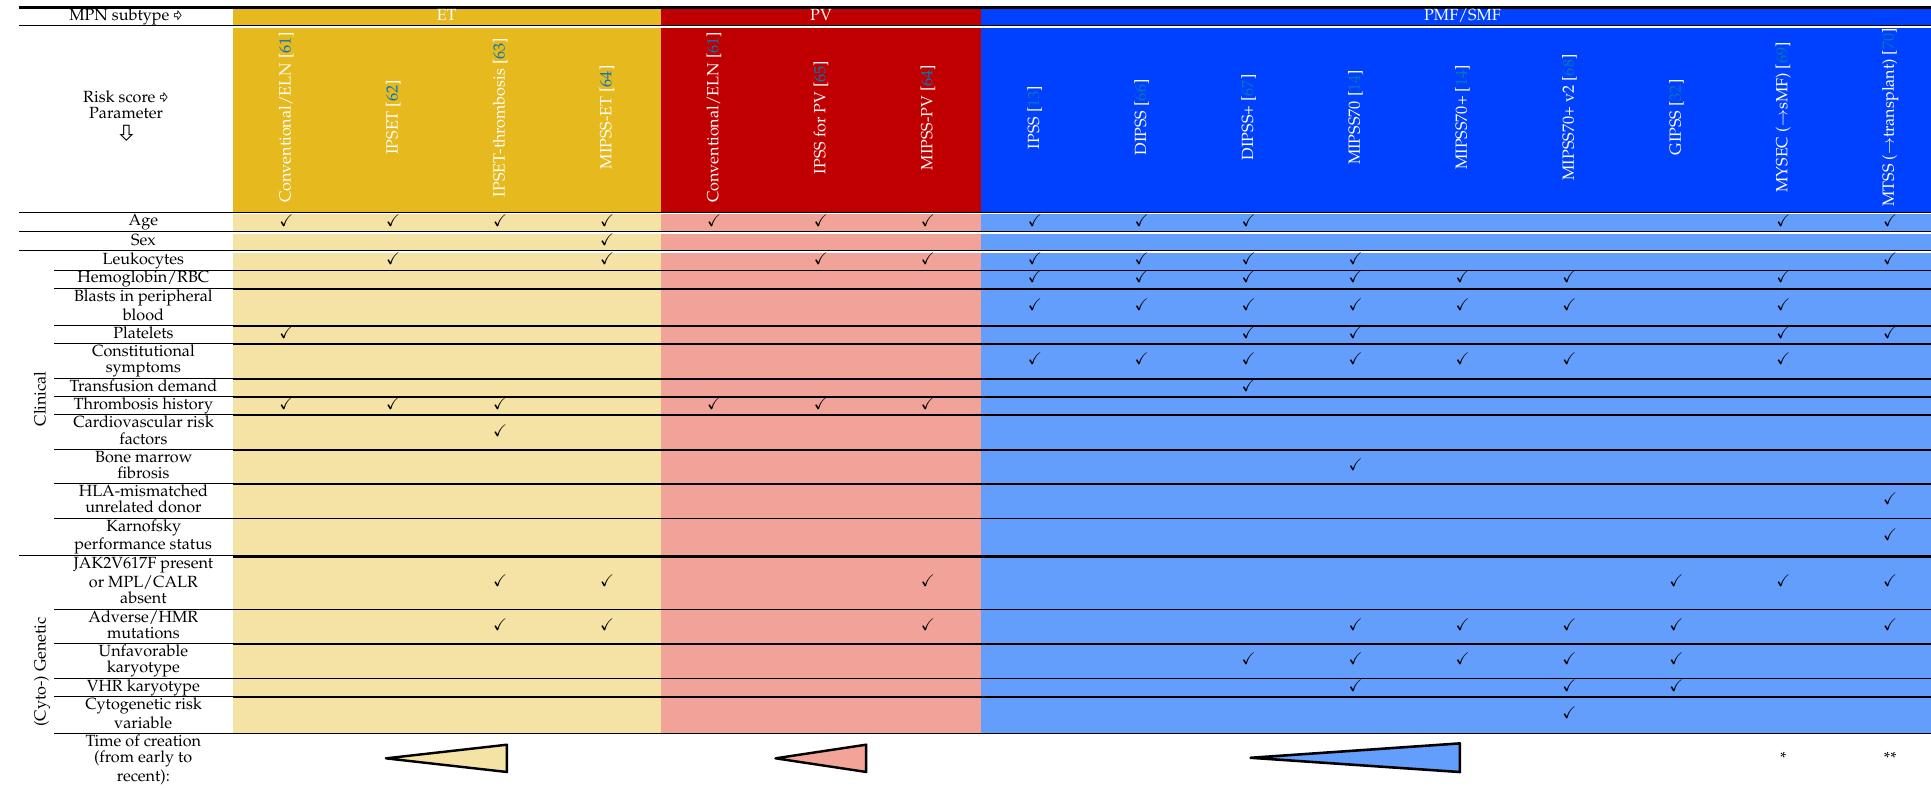
Table 1. Overview of prognostic scoring systems for ET, PV, and PMF/SMF.